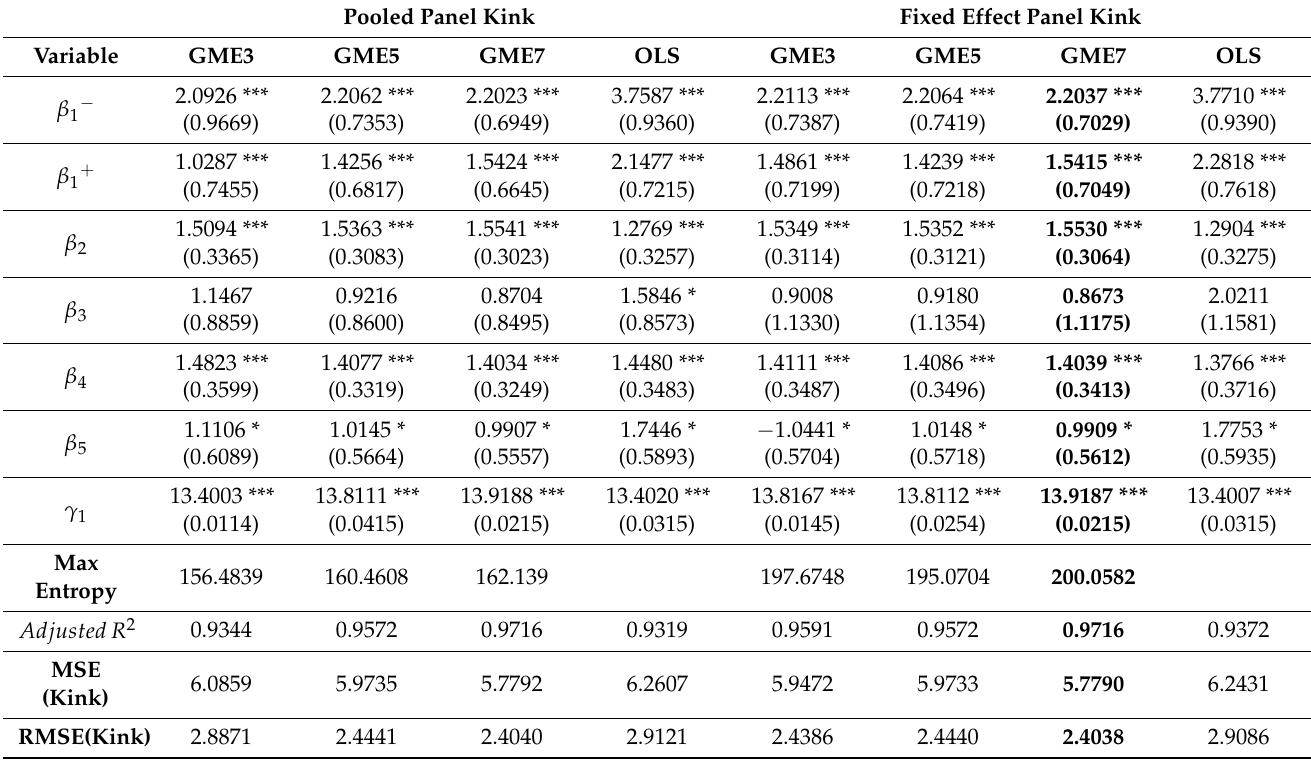
Table 6. Panel kink regreession pooled GME, Fixed effect GME, and OLS estimates. Pooled Panel Kink Fixed Effect Panel